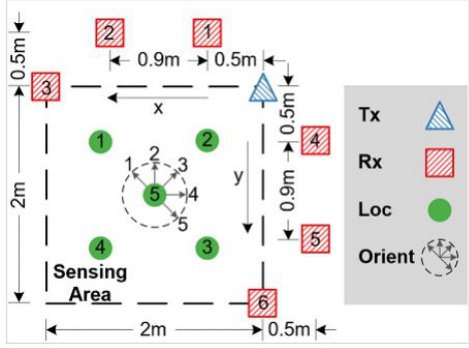
Figure 9. Experiment setup of Widar3.0 dataset, taken from [5].